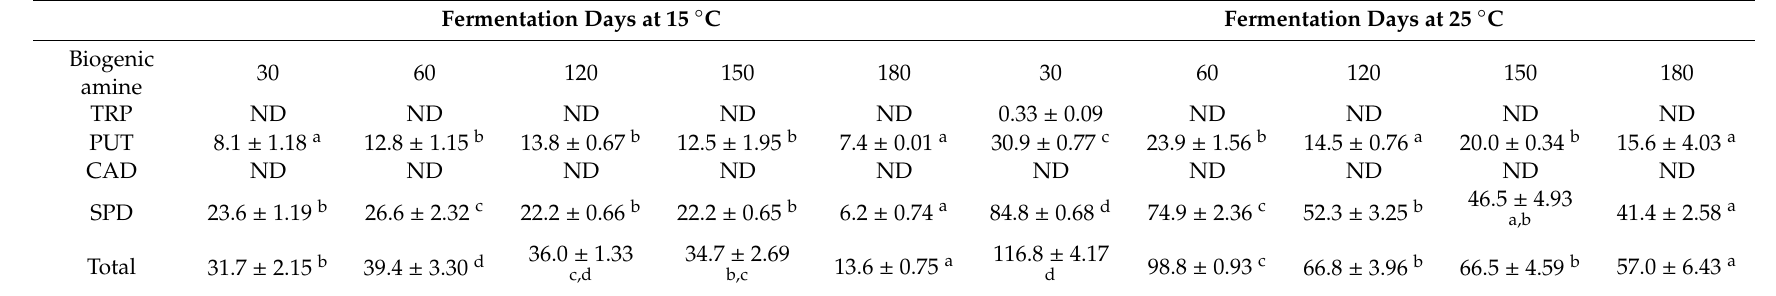
Table 3. Biogenic amines content (mg / L) during fermentation at di ff erent